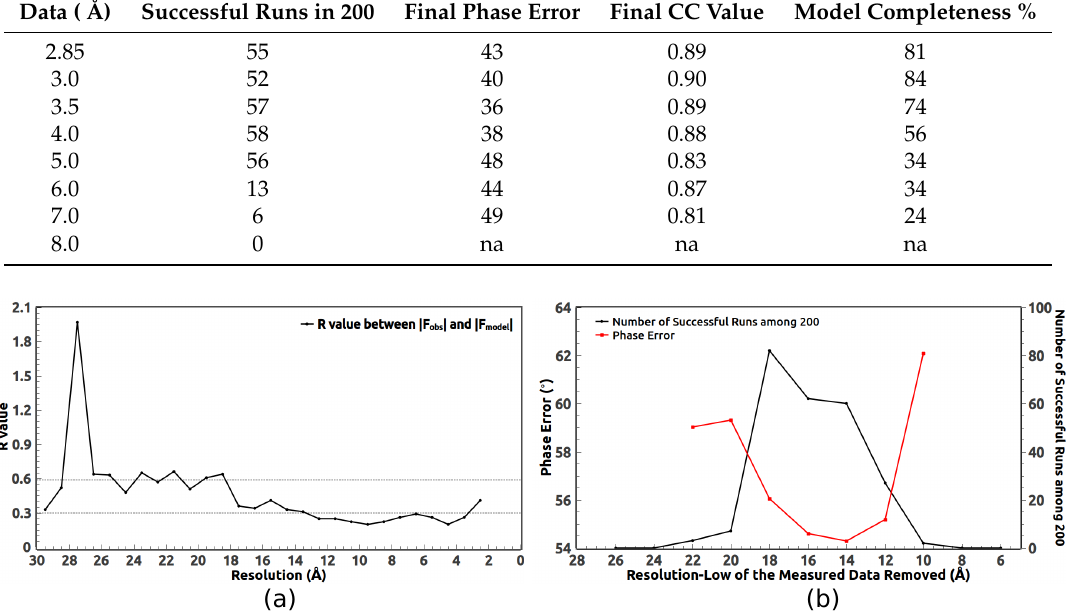
Figure 9. ( a ) R value between | F obs | and | F model | . | F obs | are the diffraction data of 2JLN measured down to 29 Å. | F model | are the synthetic data of 2JLN calculated from the PDB deposited model with bulk solvent correction. ( b ) Removal of very low resolution data is necessary for 2JLN in order to increase the success rate. When the measured low-resolution reflections are ignored up to 14 Å, a lower phase error can be